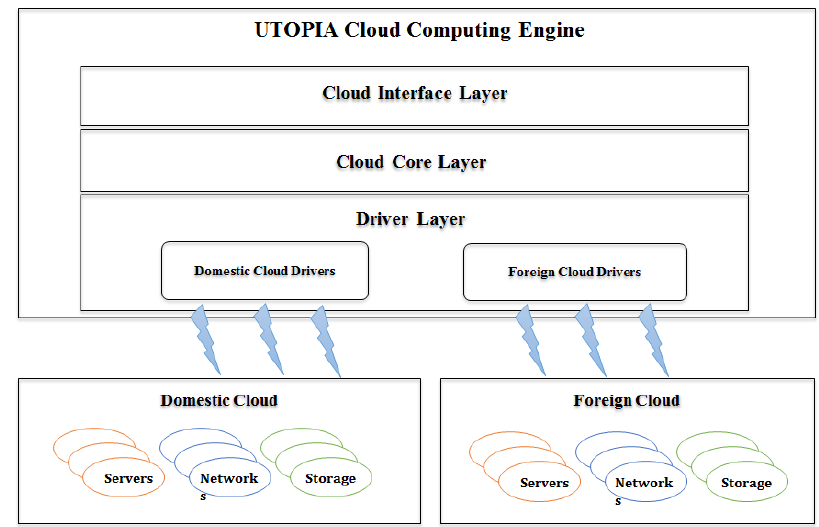
Figure 6. The architecture of the UTOPIA Cloud Computing Engine.